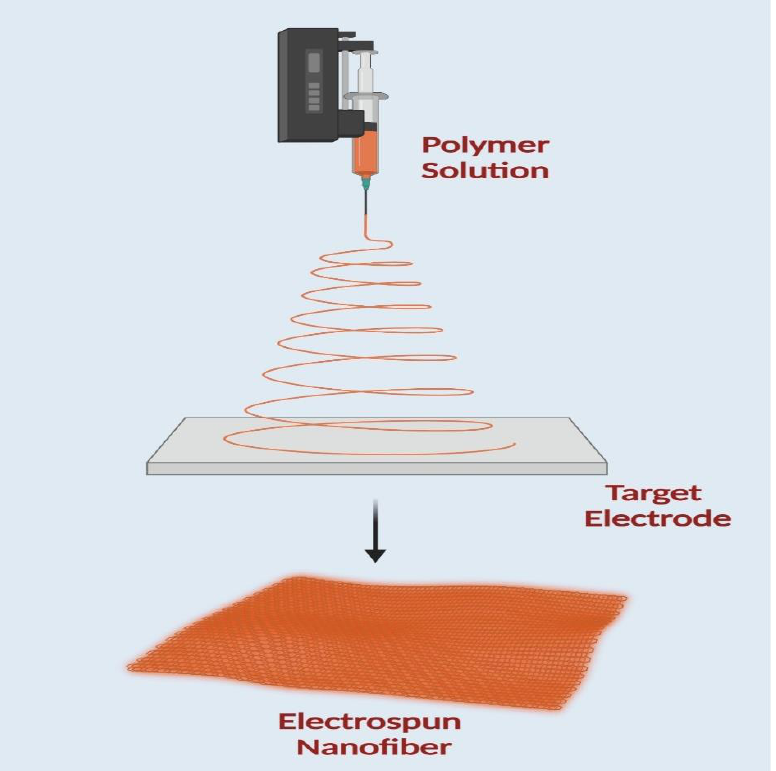
Figure 6. A schematic diagram of electrospinning apparatus.